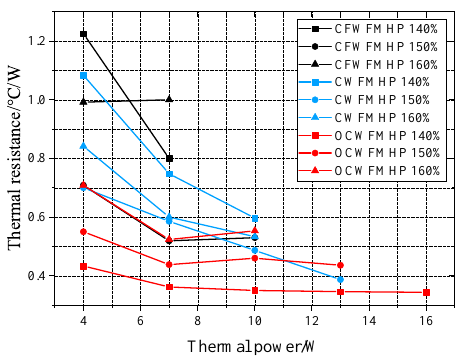
Figure 14. Thermal resistance of FMHP at different liquid filling rates. The thermal power is from 4 W to the maximum thermal power. As can be seen from Figure 14, the thermal resistance of the FMHP is larger at low thermal